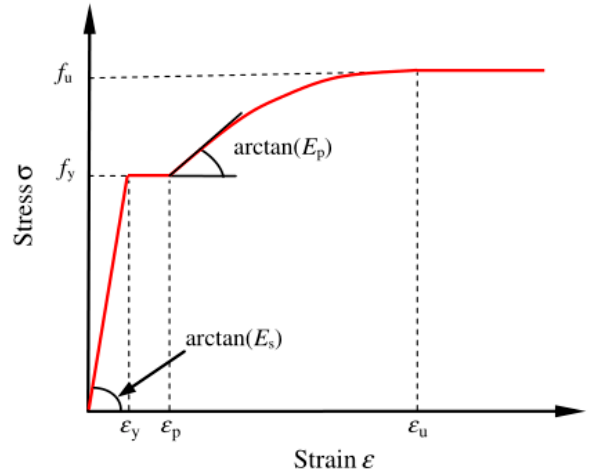
Figure 5. Stress–strain model of steel [16].